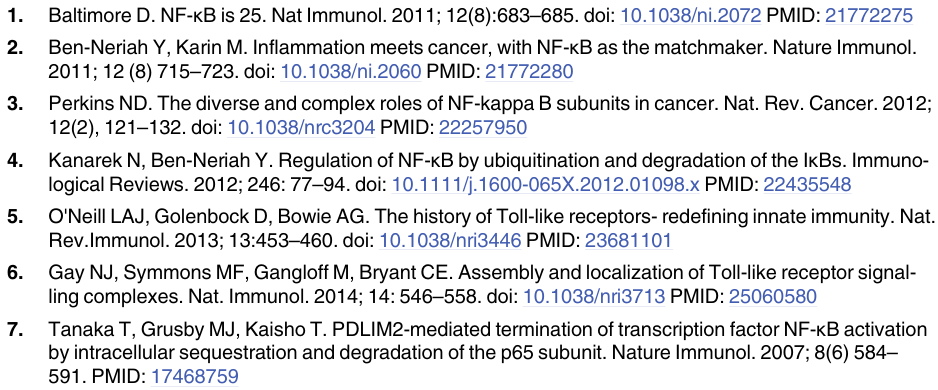
S2 Table. Protein agent messages. Agent communications in FLAME are messages sent and received by agents. Messages from Protein agents signal their location and state, as well as requests for interactions. S3 Table. Protein agent functions. Agent functions are performed in a predefined order,